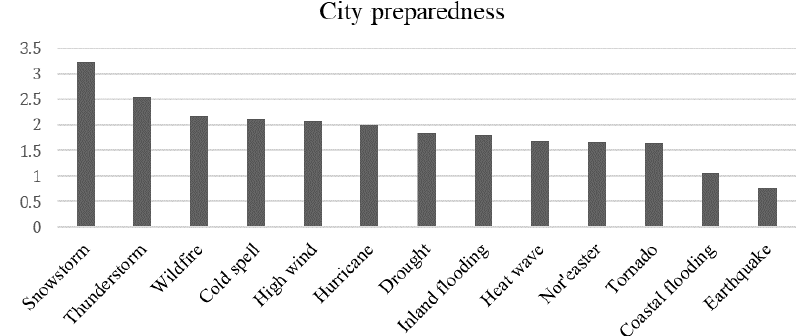
Figure 7. Survey results regarding the level of the city’s preparedness for impactful hazards potentially affecting NYC out of a maximum of 5